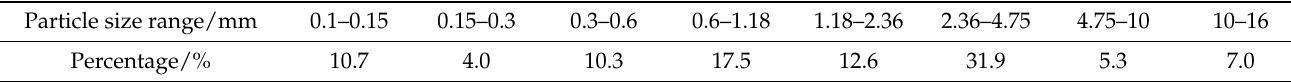
Table 4. Quartz sand grading.